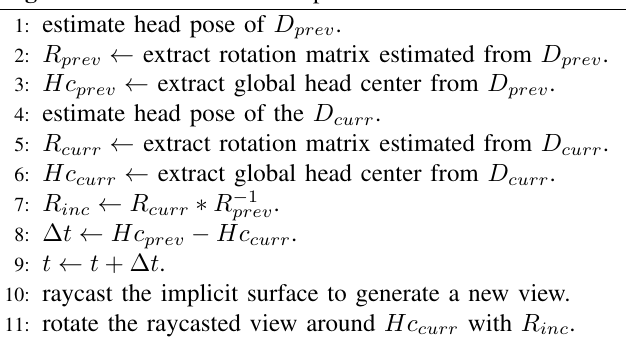
detected, we fix the window that contains the face region.